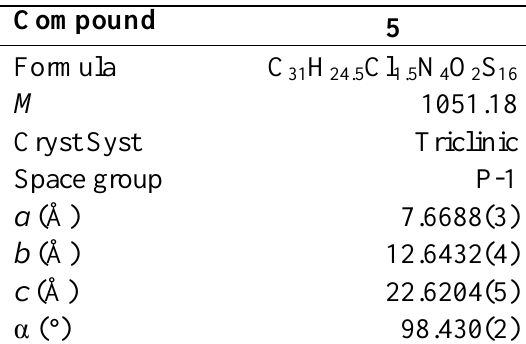
(tcnoprOH)(CHCl 2